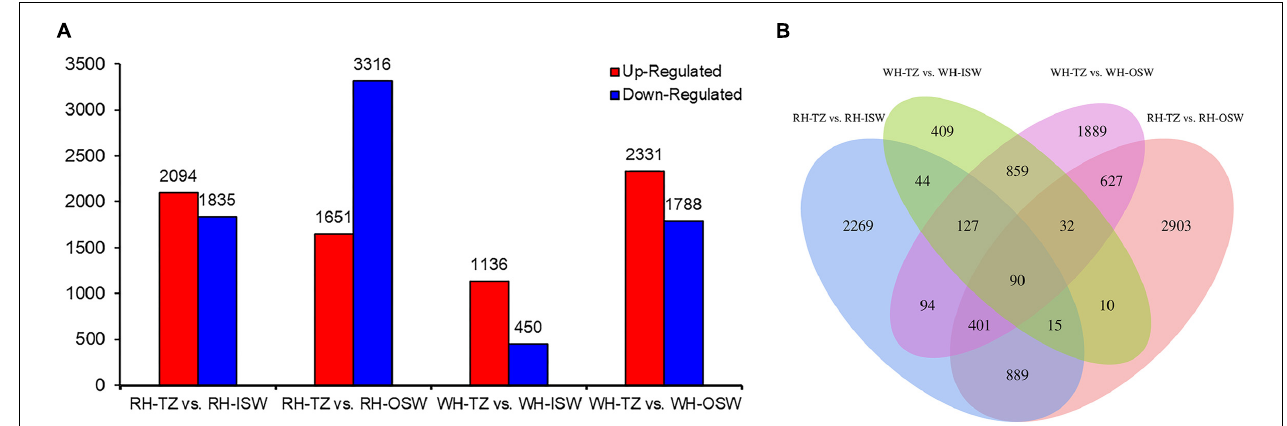
FIGURE 7 | Statistic of differentially expressed genes. (A) The number of upregulated and downregulated differentially expressed genes (DEGs) in group RH-TZ vs. RH-ISW, RH-TZ vs. RH-outer sapwood (OSW), WH-TZ vs. WH-inner sapwood (ISW), and WH-TZ vs. WH-OSW. (B) Venn diagram analysis of DEGs. RH, red-heartwood; WH, white-heartwood; TZ, transition zone; ISW, Inner Sapwood; OSW, Outer Sapwood. Differentially expressed genes were identified by p ≤ 0.05 and the absolute value of log2 ratio ≥